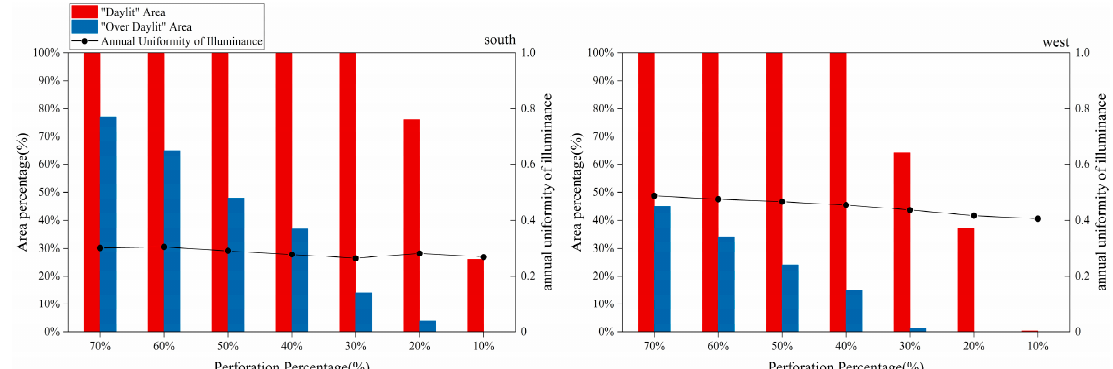
Figure 6. Shading and daylighting performance for the tested cases in Group 1.